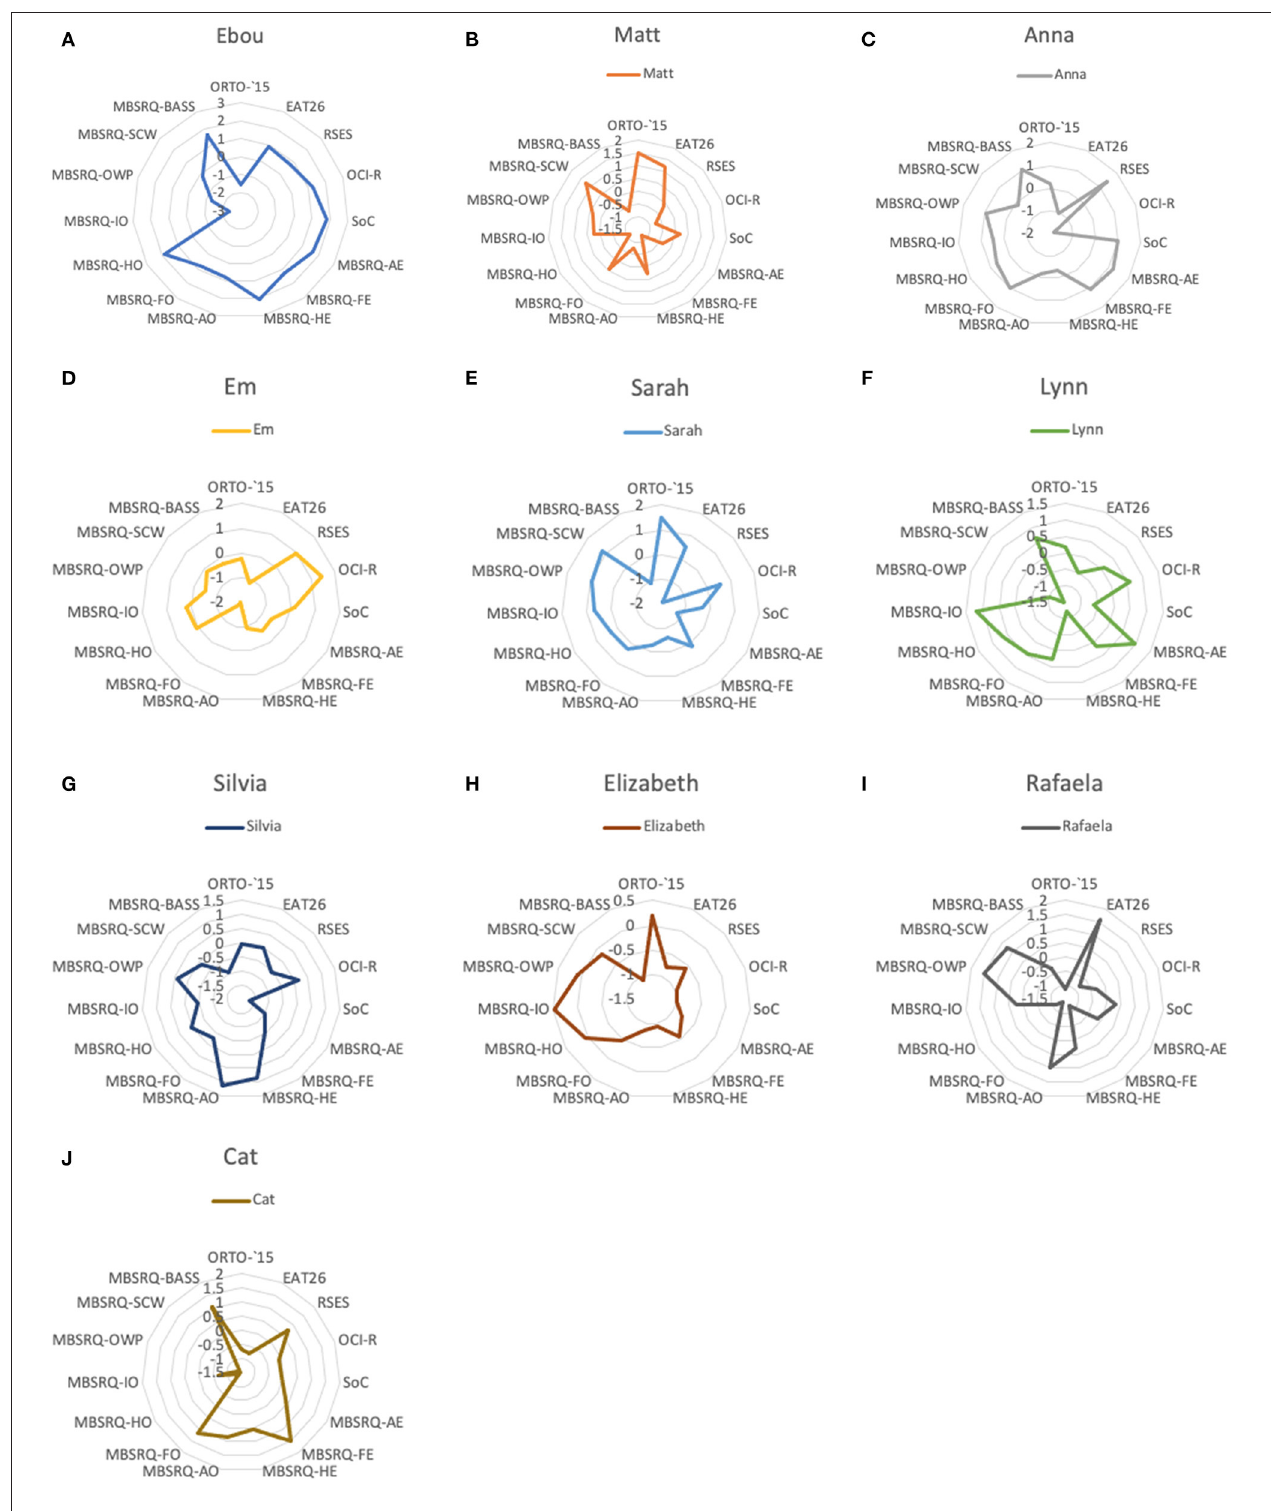
FIGURE 1 | (A) Ebou’s scores on psychometric measures. (B) Matt’s scores on psychometric measures. (C) Anna’s scores on psychometric measures. (D) Em’s scores on psychometric measures. (E) Sarah’s scores on psychometric measures. (F) Lynn’s scores on psychometric measures. (G) Silvia’s scores on psychometric measures. (H) Elizabeth’s scores on psychometric measures. (I) Rafaela’s scores on psychometric measures. (J) Cat’s scores on psychometric measures. The chart